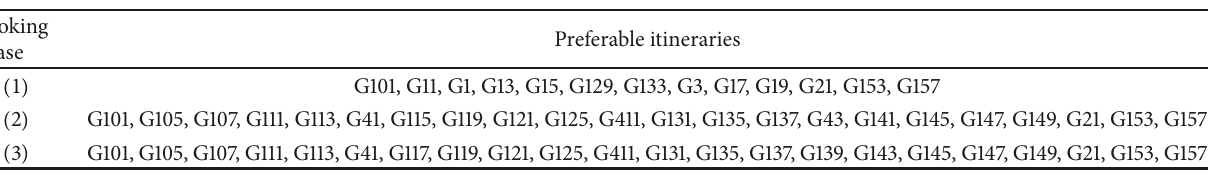
Table 8: The booking phase scheme.